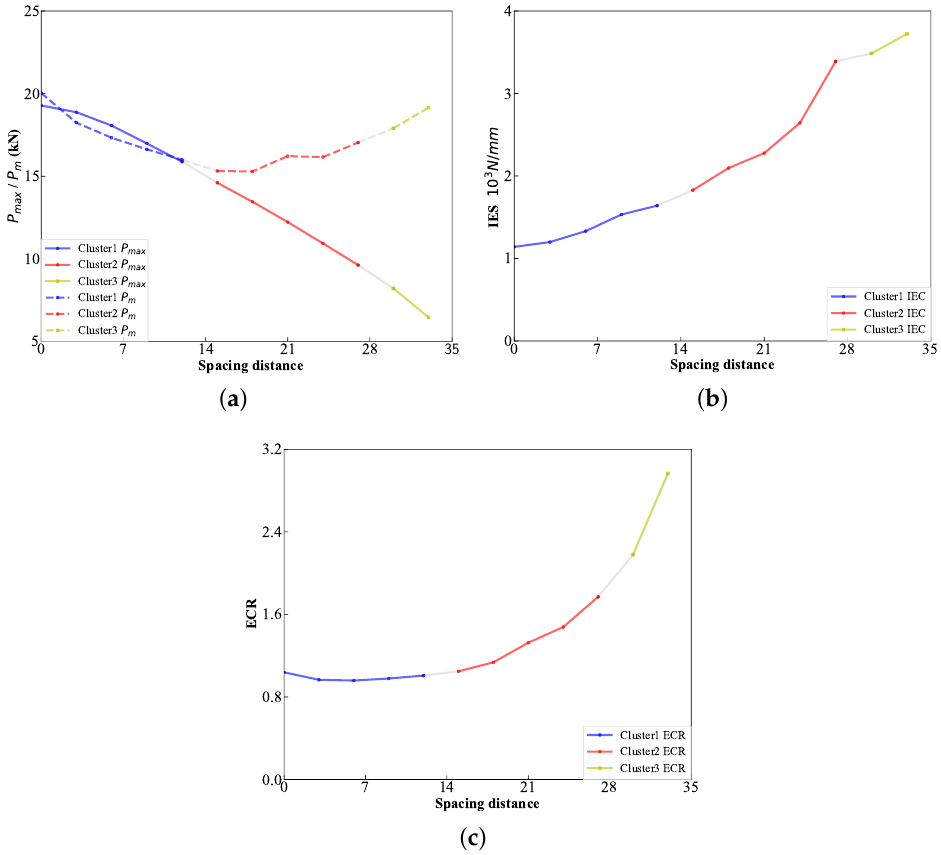
Figure 16. P max , P m , IEC and ECR of the secondary clustering model: ( a ) P max and P m ; ( b ) IEC ; ( c ) ECR . Here, the gray line only works as a